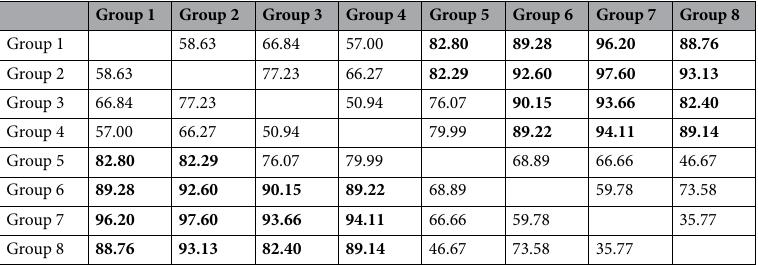
Table 2. Accuracy of binary classification between altitude groups, the cases of good discrimination, over 80%, are highlighted by